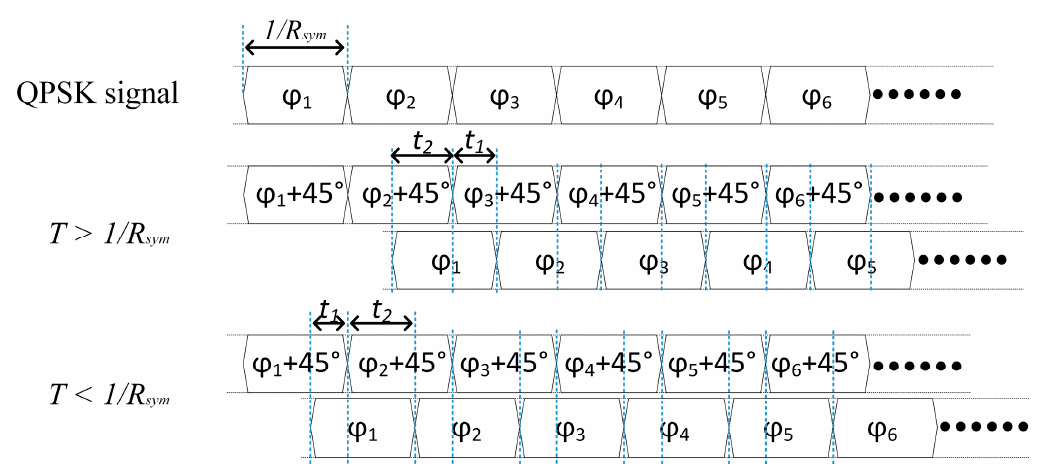
Figure 4. Two cases of free spectral range (FSR) adjustment. R sym is the symbol rate, t 1 is the period during which a single symbol interferes with itself or the next second one, and t 2 is the period during which a single symbol interferes with its adjacent symbol.